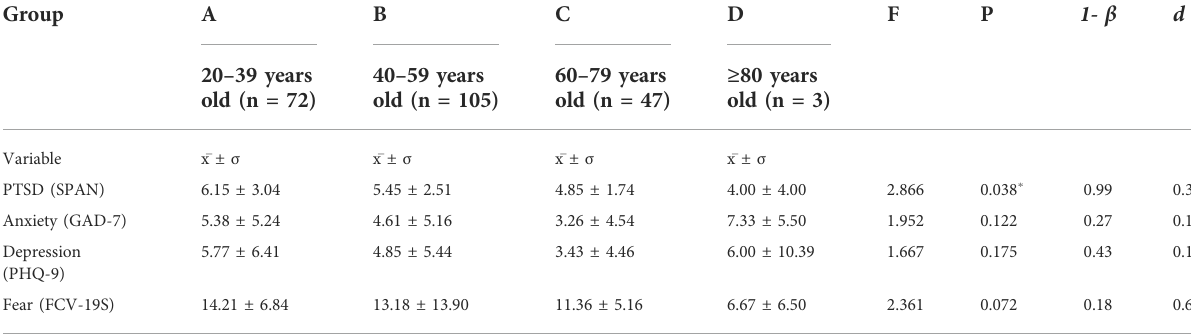
TABLE 4 Differences between age groups in the PTSD, anxiety, depression, and fear to covid-19 scores. Group